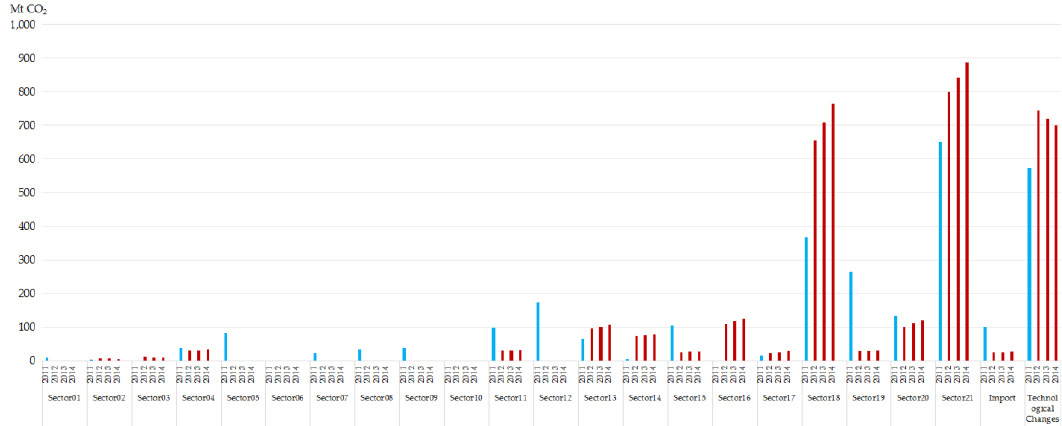
Figure 4. ERCE embodied in CSFAI caused by the final demand increase of each sector and technological changes from 2011 to 2015.